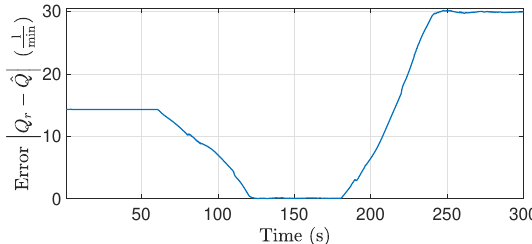
Figure 7: The absolute error between the model ( Q r ) and estimated ( ˆ Q ) flow